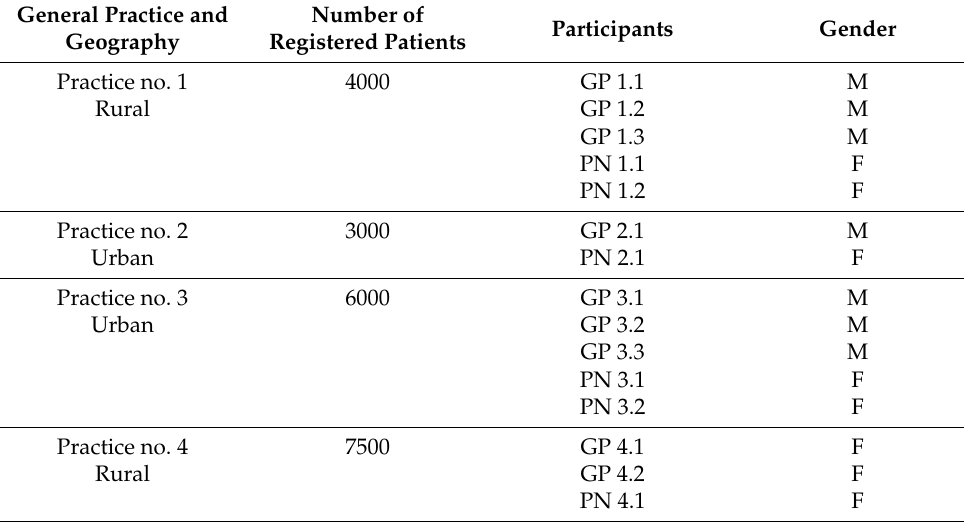
Table 2. Participant characteristics.